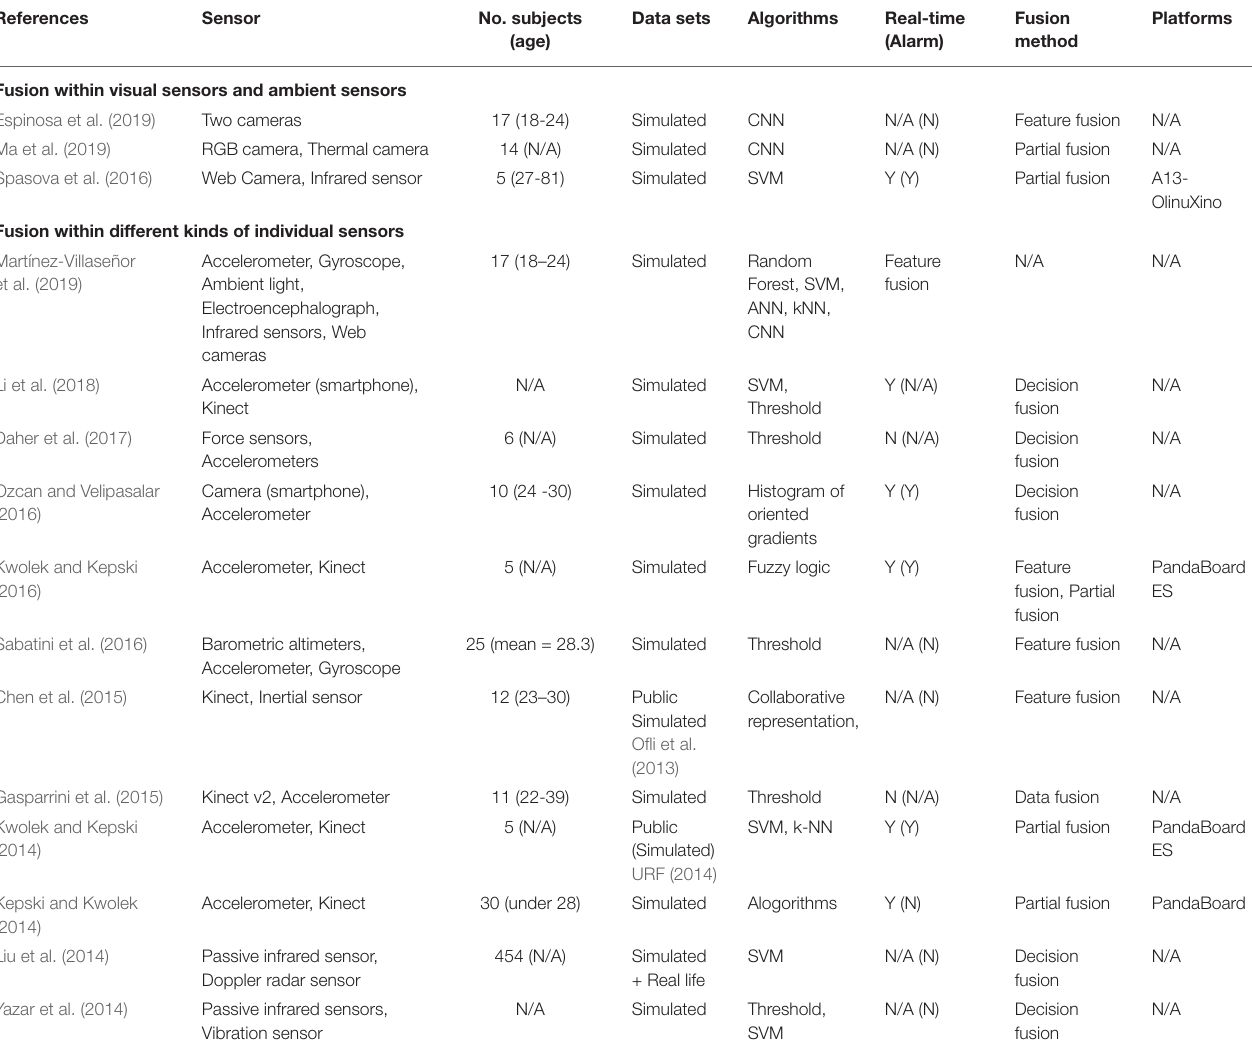
TABLE 7 | Fall detection using fusion of sensor networks from 2014 to